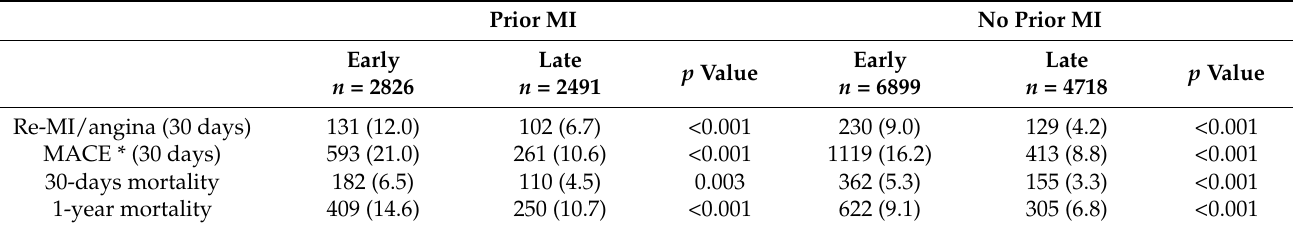
Figure 2. Kaplan–Meier survival curves stratified by prior MI and by time periods (early/late). Log rank with pairwise comparisons with Holm’s adjustment to p -value. A propensity matched analysis between the early and late periods for patients with Table 4. Clinical outcomes of patients with and without prior MI between time periods (early 2000–2008 vs. late 2010–2018) prior MI and no prior MI was performed. The resultant matched sample consisted of 1809 matched pairs for prior MI and 4490 pairs for no prior MI. Variables used in the model after propensity score matching.